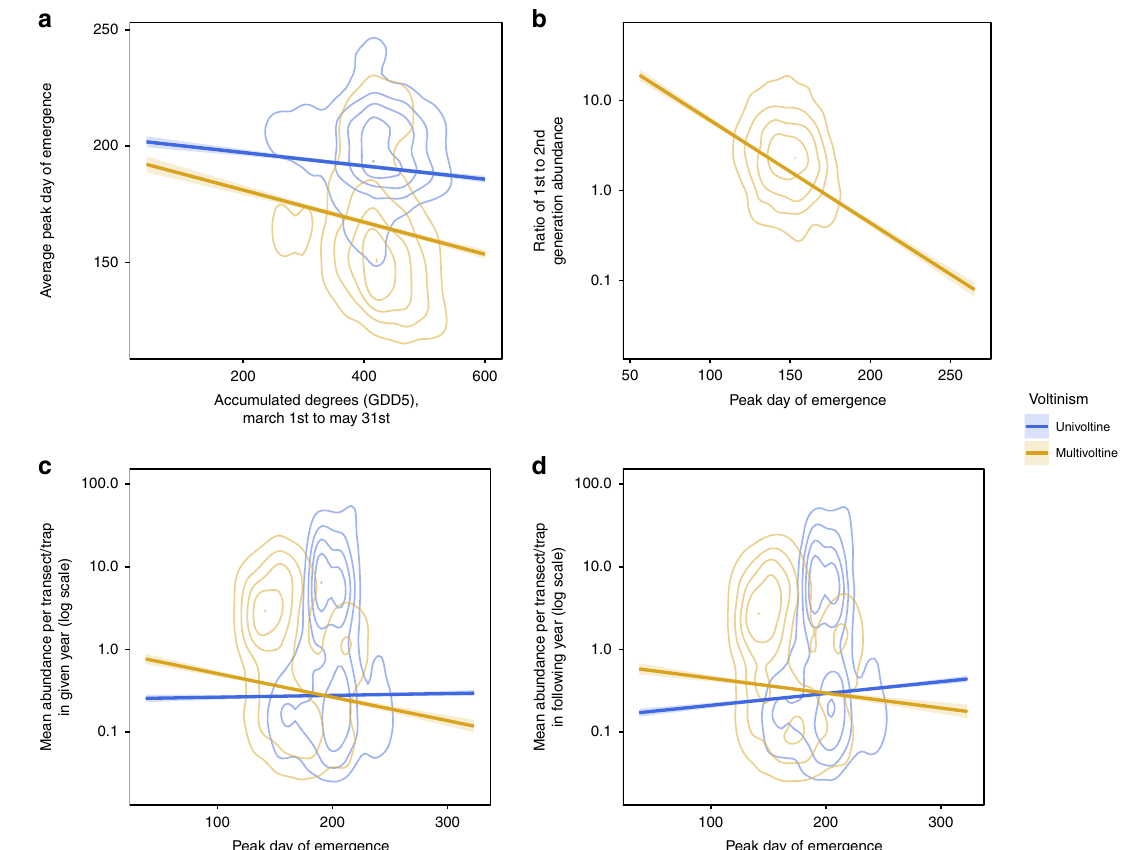
Fig. 3 Species ’ responses to annual variation in spring temperature depend on voltinism. Lines depict model-predicted relationships ± 95% con fi dence interval, from generalised linear mixed-effects models fi tted to annual population-level estimates of emergence date and abundance for all univoltine and multivoltine species. The relative density of underlying data points is represented by contour lines. Colour indicates voltinism (blue: univoltine species, orange: multivoltine species). a Average peak day of fi rst-generation emergence is earlier in years with warmer springs (measured as the accumulated growing degree days above 5 °C (GDD5) between 1st March and 31st May) for both univoltine and multivoltine species, and the effect is signi fi cantly stronger for multivoltine species. b In multivoltine species, abundance in second and subsequent generations is proportionally larger compared with the fi rst generation (as indicated by a larger intergenerational abundance ratio) in years when peak day of fi rst-generation emergence was earlier. c Abundance of multivoltine species (measured as the mean number of individuals recorded per transect/trap) is greater in years when peak day of fi rst-generation emergence was earlier, but there is no relationship for univoltine species. d Abundance of multivoltine species is greater when peak day of fi rst generation in the previous year was earlier, but abundance of univoltine species is greater when peak day of fi rst-generation emergence in the previous year was